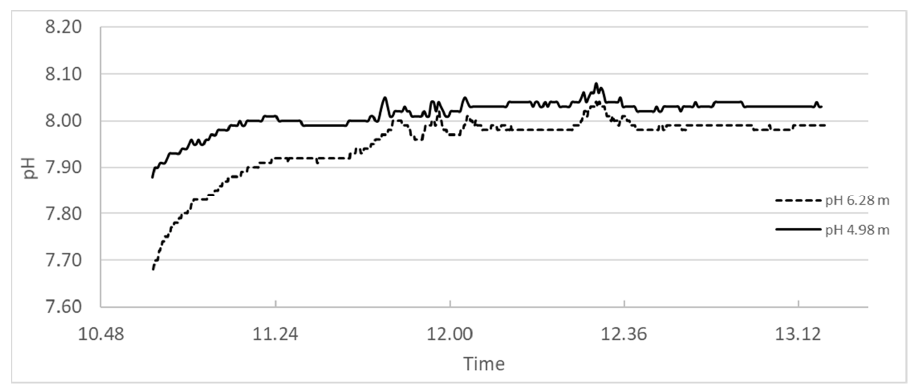
Figure 19. pH measured in open sea in the area where a suspension of coarse CaO was sprayed.